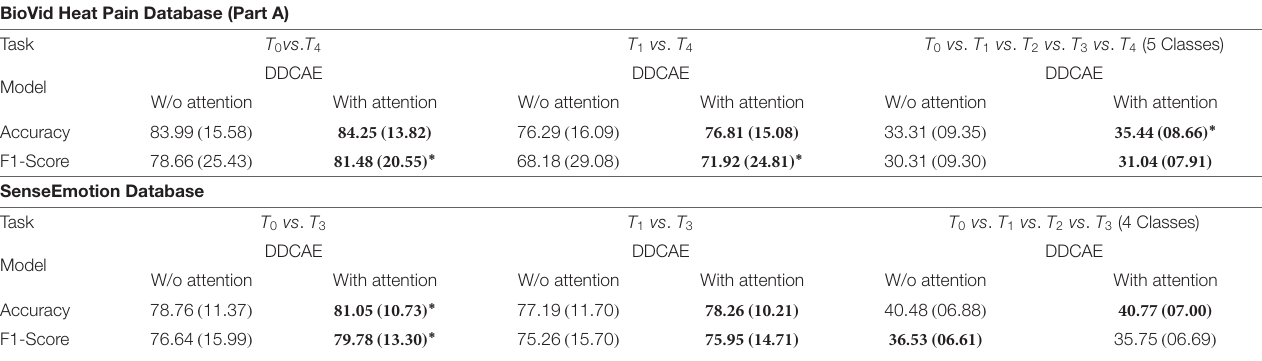
TABLE 4 | Classification performance comparison in a Leave One Subject Out (LOSO) cross-validation evaluation setting: Average Performance in % (Standard Deviation in % ). BioVid Heat Pain Database (Part